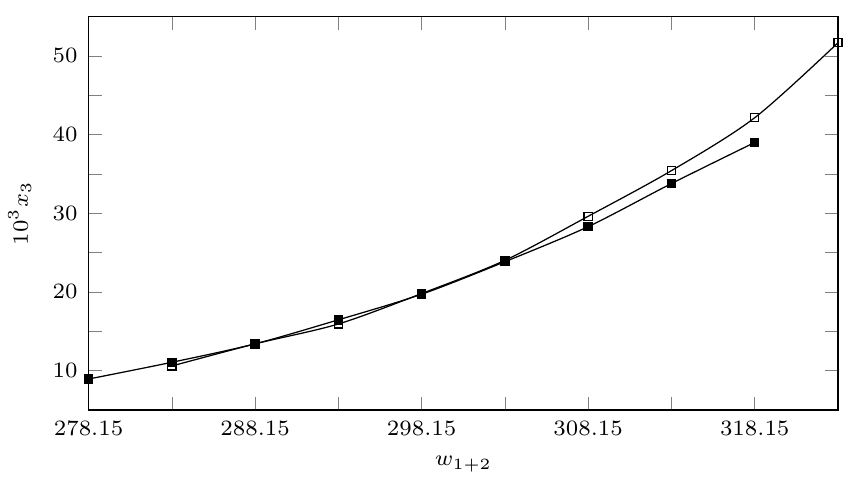
Figure 6. Experimental solubility of isoniazid in pure water (cid:3) : Gong et al. [12]; (cid:4) : this